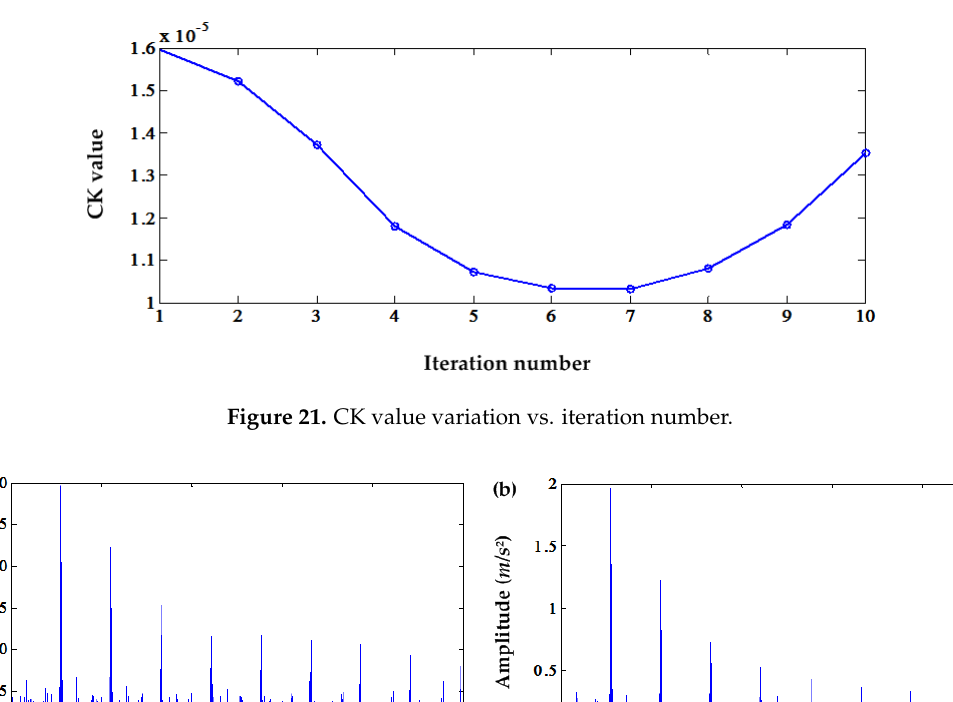
Table 3. Characteristic frequencies (Hz).